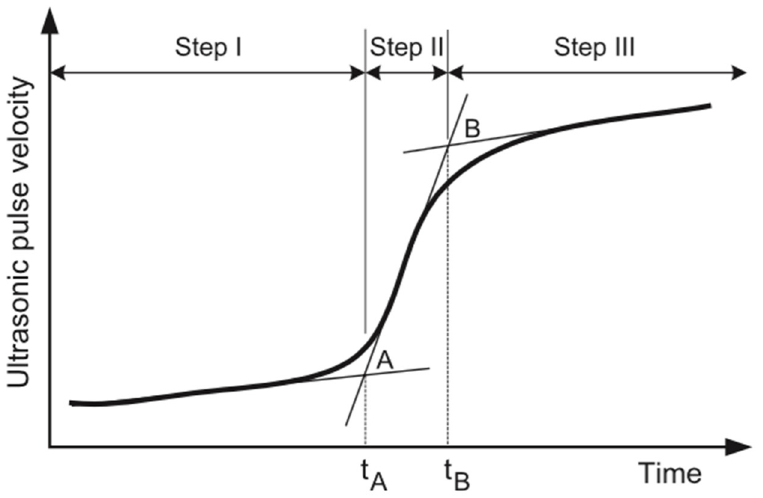
Figure 5. Evolution of the ultrasonic pulse velocity (UPV) of cementitious materials after